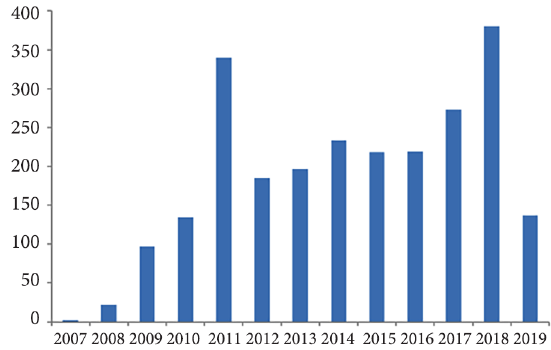
Figure 3. Annual distributions JEELM’s citation number (2007–2019)